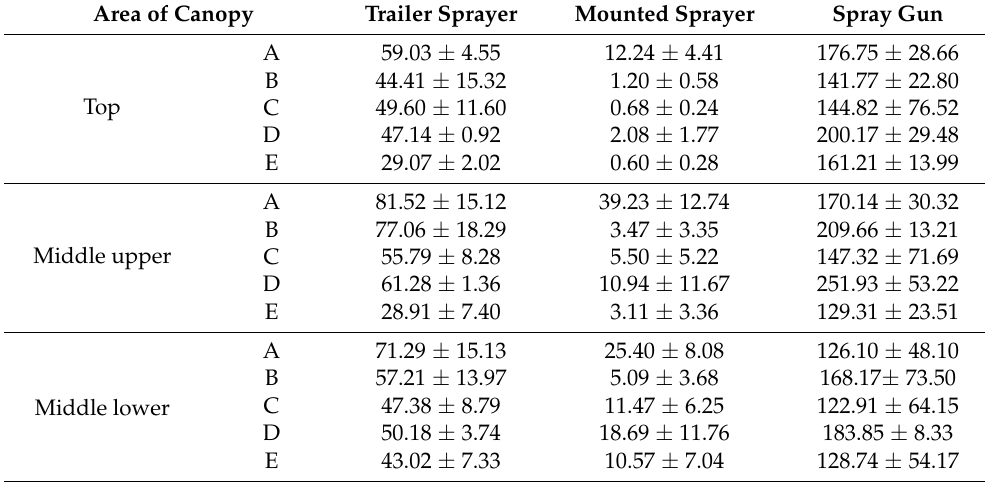
Table 6. Deposition amount ( µ L) and average deposition ( µ L) of spray liquids in pear